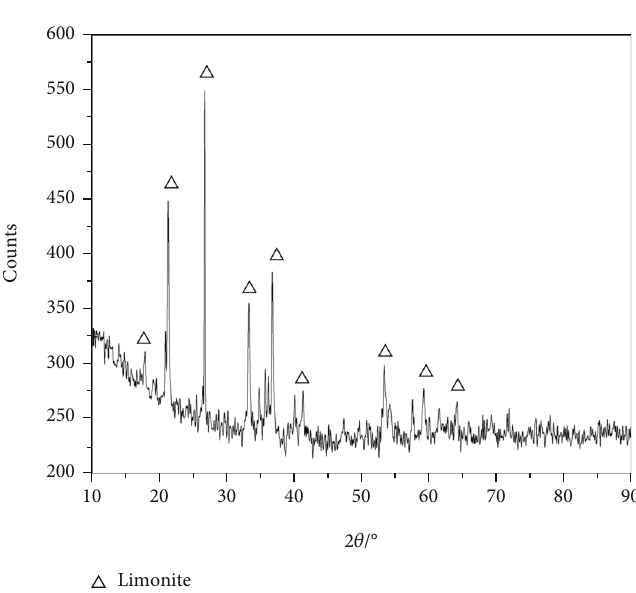
Figure 2: X-ray di ff raction pattern of the limonite